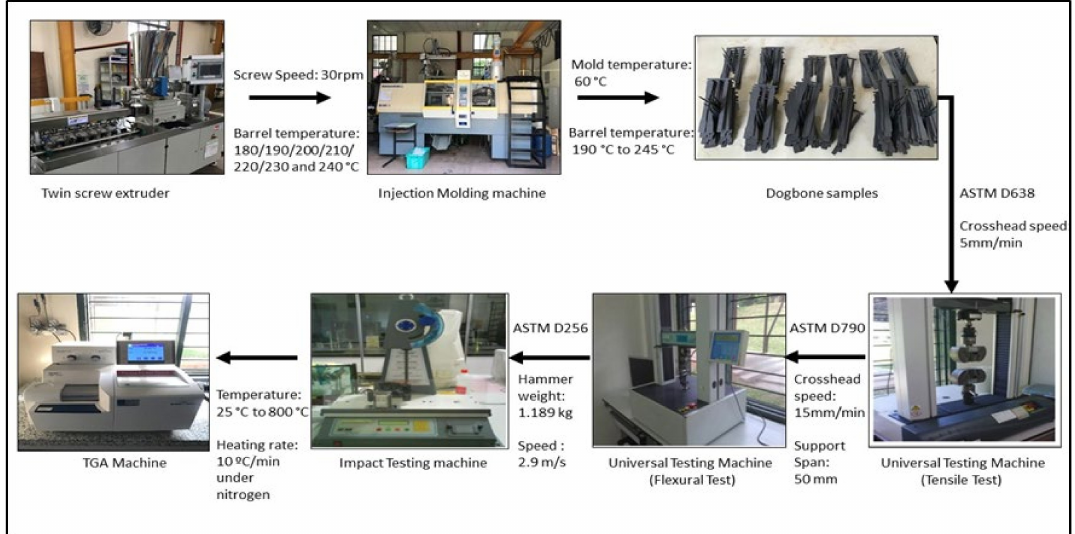
Figure 1. Schematic diagram of the production of ABS/Talc/GO/SEBS-g-MAH through melt